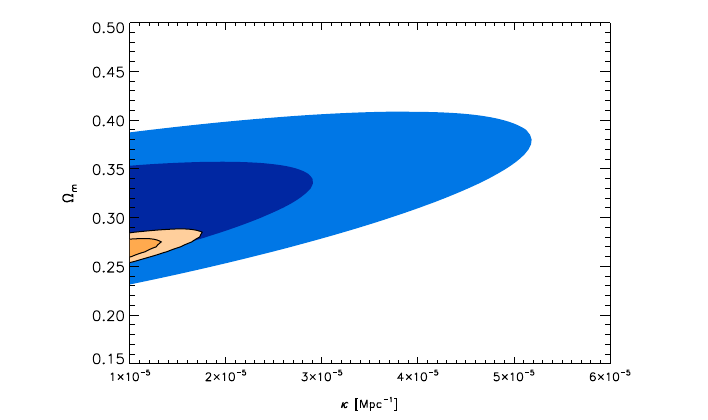
Fig. 57 Constraints on MCP models. Blue regions represent current constraints while orange are forecast Euclid constraints assuming it is accompanied by a Dark Energy Task Force stage IV supernovae sample. Image reproduced with permission from Avgoustidis et al. (2010), copyright by